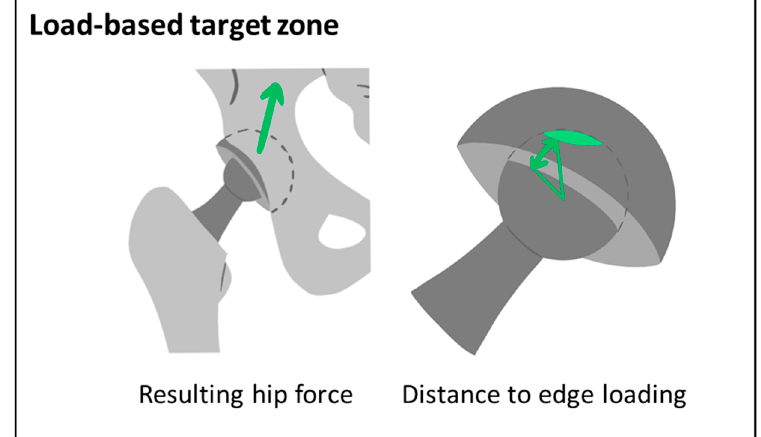
Figure 5. Criteria considered for the load-based target